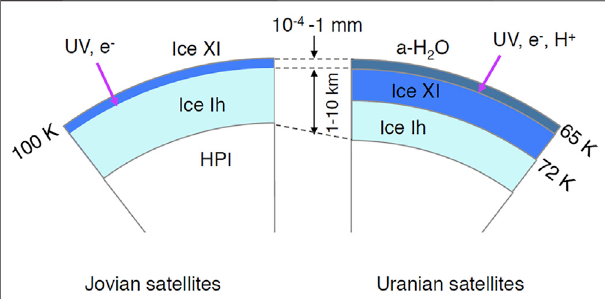
FIGURE10| SchematiccrosssectionsoficysatellitesinJovian(left)and Uranian regions (right). HPI, high-pressure ices. Penetration depths of UV- rays, 1 MeV electrons, and 1 MeV protons are ∼ 100 nm, 4 mm, and ∼ 2 × 10 – 2 mm, respectively.